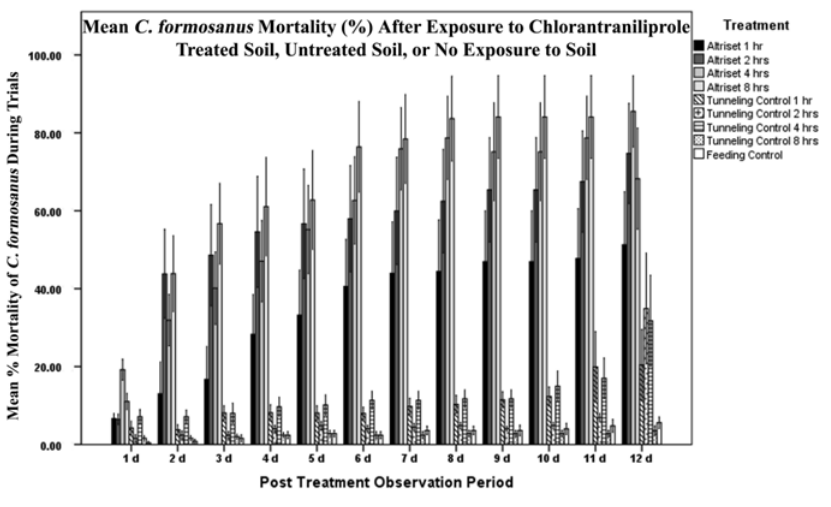
Fig. 3. Mean accumulated FST % mortality through 12 d of